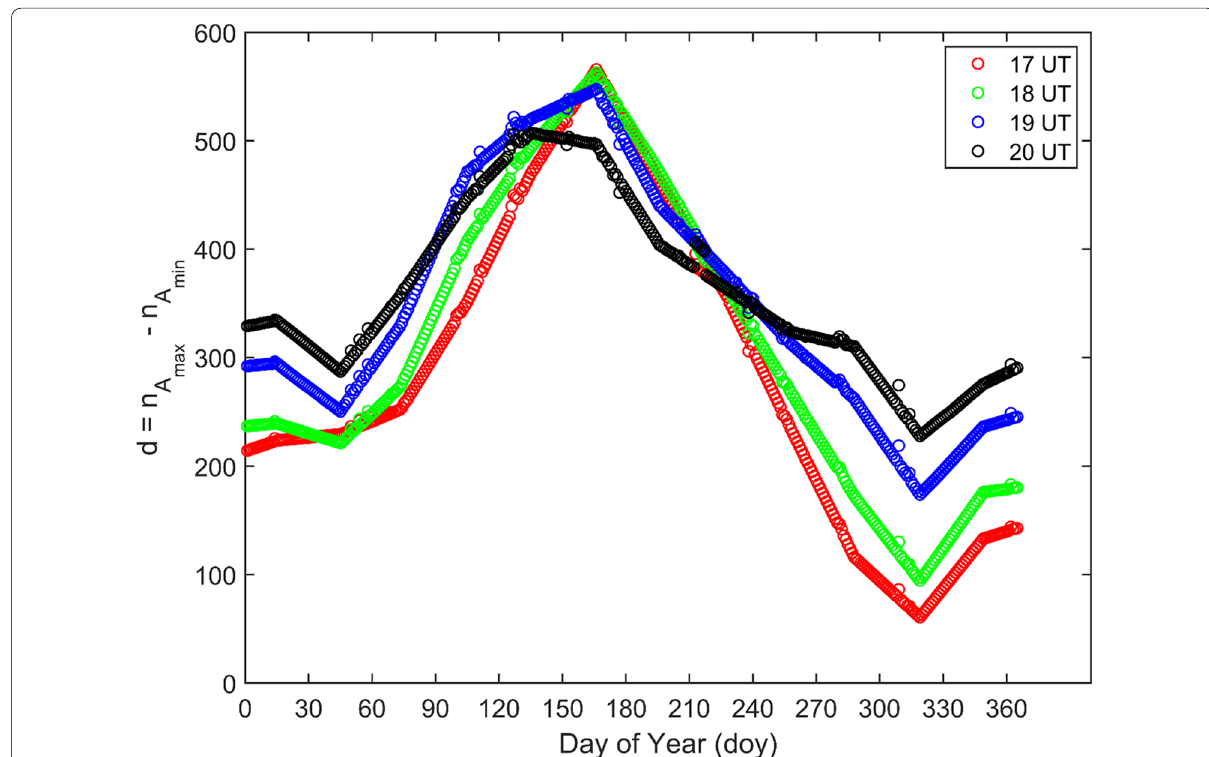
Fig. 8 The value of depth of the well formed by the minimum and maximum refractive index at the region above the E-layer and the F-layer peak, − n respectively, d = ( n A A min ) plotted for the entire year of 2018 max